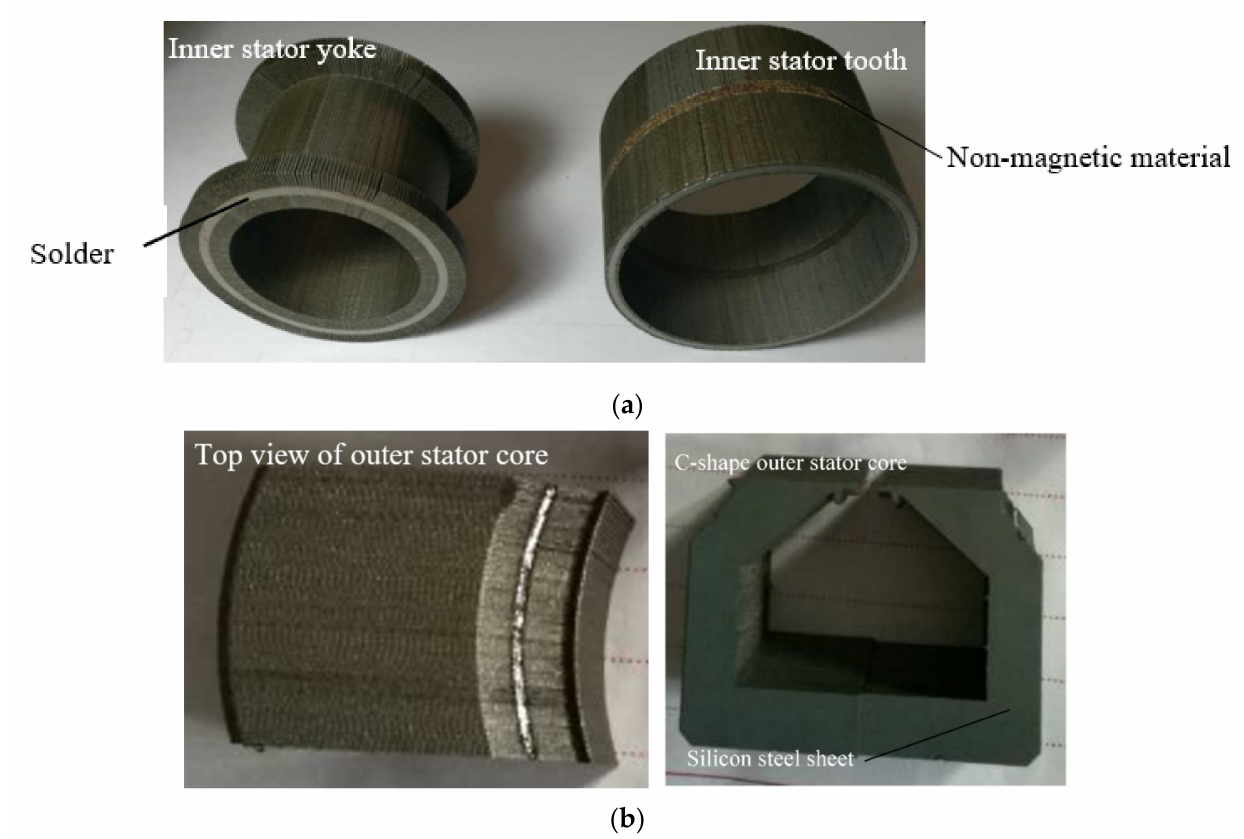
Figure 6. Stator core laminations of the proposed models: ( a ) Inner stator yoke tooth; ( b ) Outer stator